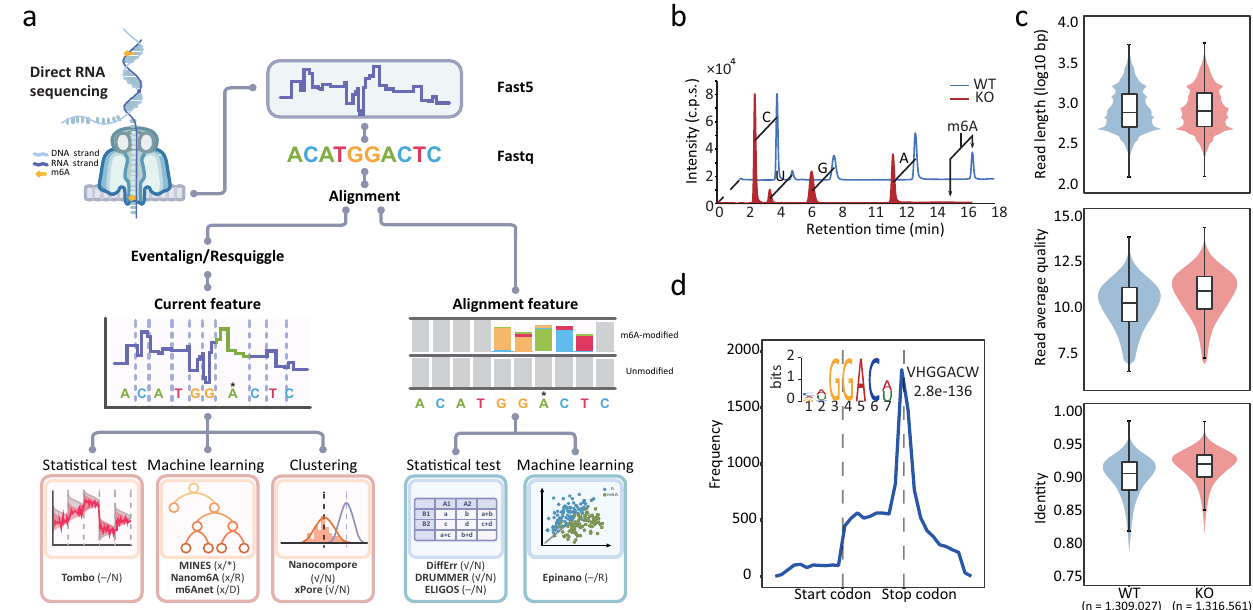
Fig. 1 | Tools and datasets used for m6A mapping based on the ONT DRS platform. a Pipeline and strategies employed by various m6A mapping tools. Information on the requirement for a negative control, minimum coverage and motif speci fi city for each tool is shown in brackets. “ √ ” and “ x ” indicate the requirement for a negative control, while “ - ” indicates that a negative control is optional. “ N ” indicatesalackofmotiflimitations,while “ D ” and “ R ” indicateDRACH and RRACH, respectively. Note that MINES detects m6A in AGACT and GGACH